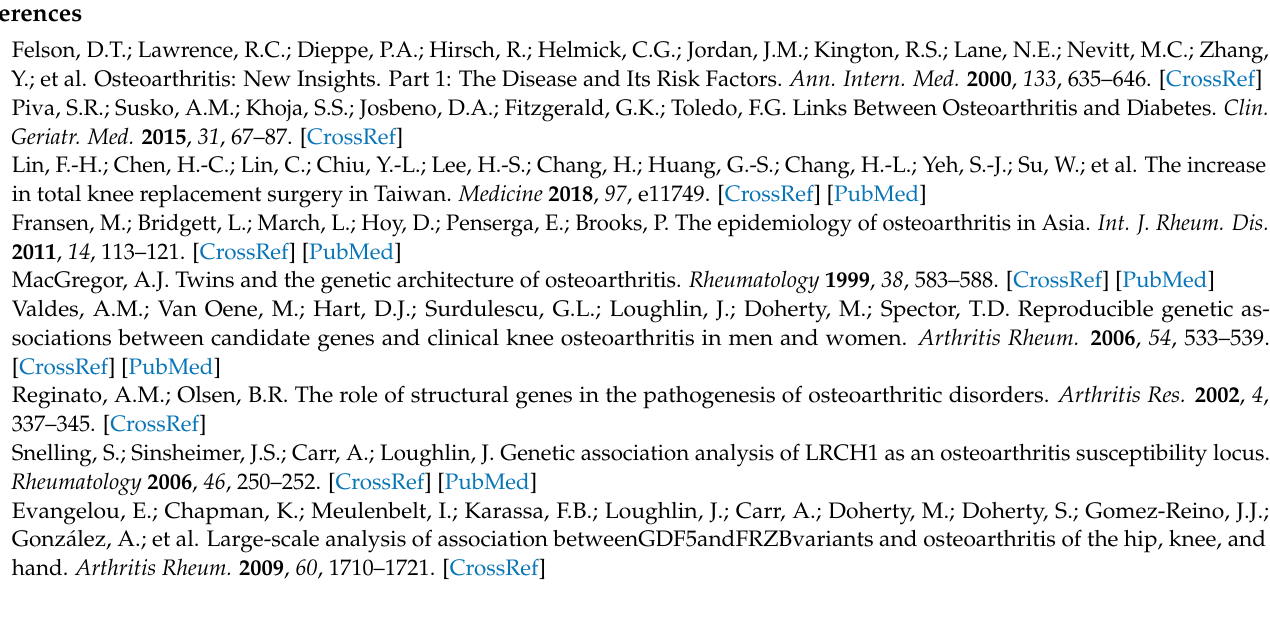
Table S3: Characteristics of gender stratified subjects with knee osteoarthritis and control subjects, Table S4: The association between ESR1 XbaI and knee OA in gender-stratified case–control